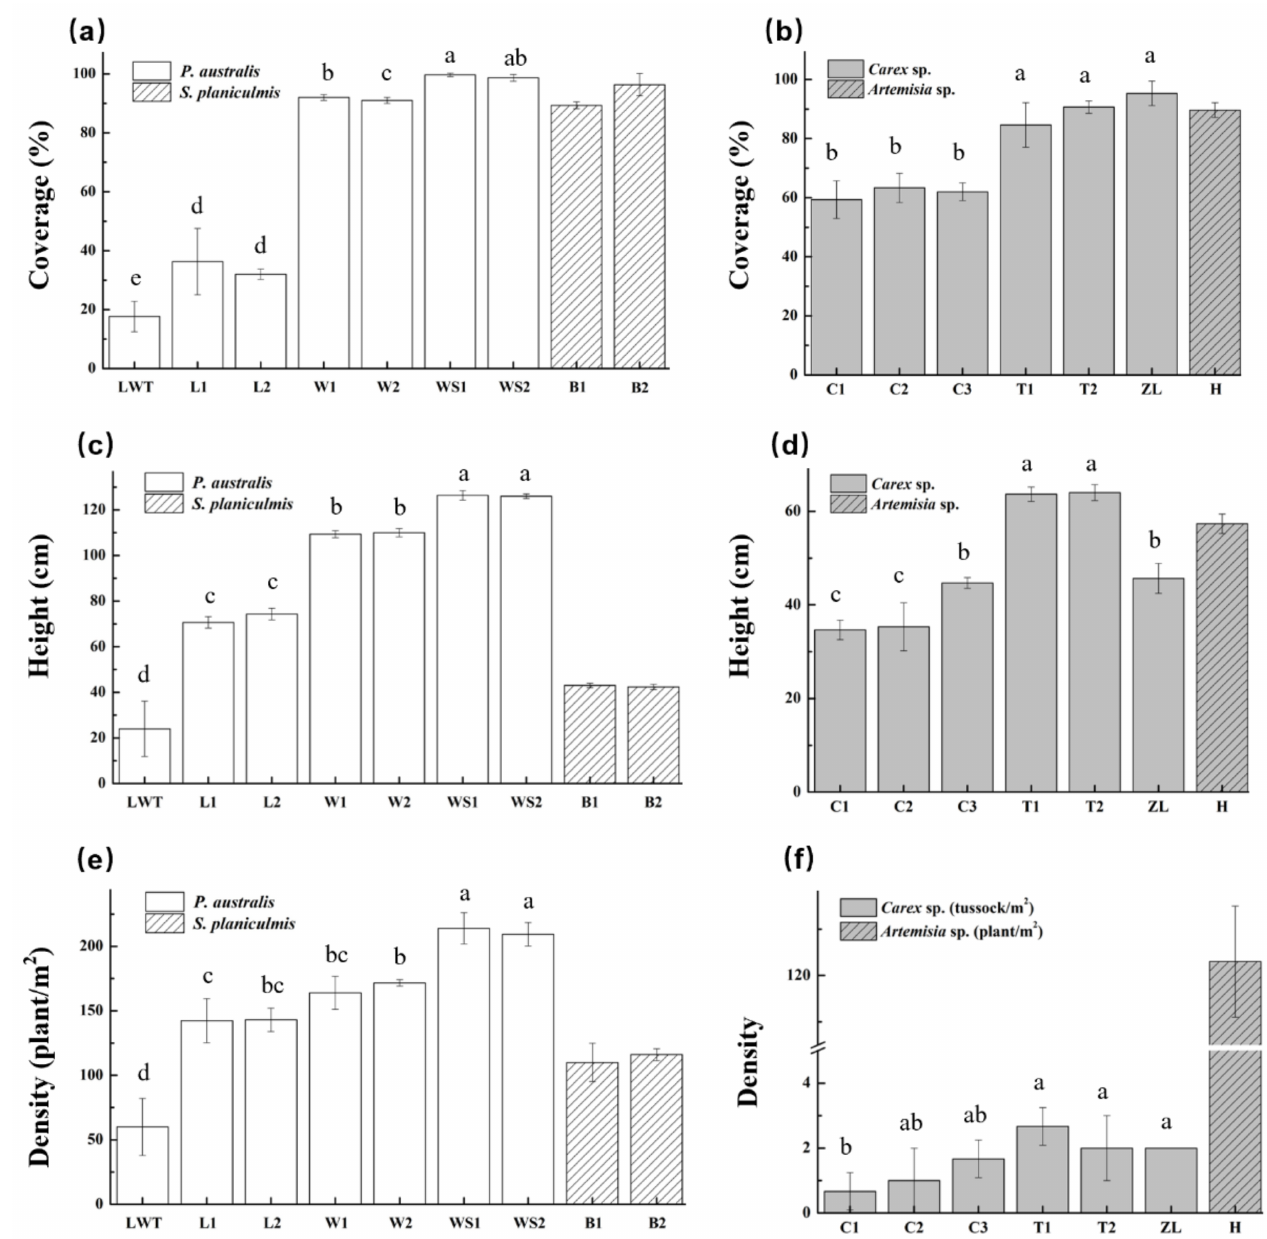
Figure 2. ( a ) Coverage of aboveground vegetation in the Phragmites marsh sampling sites; ( b ) coverage of aboveground vegetation in the Carex marsh sampling sites; ( c ) height of aboveground vegetation in the Phragmites marsh sampling sites; ( d ) height of aboveground vegetation in the Carex marsh sampling sites; ( e ) density of aboveground vegetation in the Phragmites marsh sampling sites; ( f ) density of aboveground vegetation in the Carex marsh sampling sites. Error bars represent one standard deviation of the mean ( n = 3). Different letters above the bars indicate significant differences ( p < 0.05) among different sites, calculated by one-way